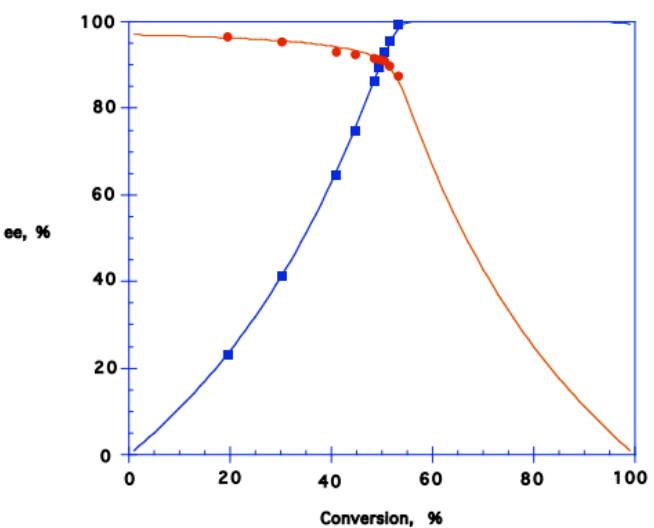
Figure 3. Enantiomeric excess ee (%) of chlorohydrin ( R )- 5a (blue squares) and the product ester ( S )- 6a (red circles) as functions of conversion (%). The enantiomeric ratio was determined to be E = 67 (“E&K calculator 2.1b0PPC” [24]). After 14 h, an ee of 99% for 5a was obtained at 53% conversion.